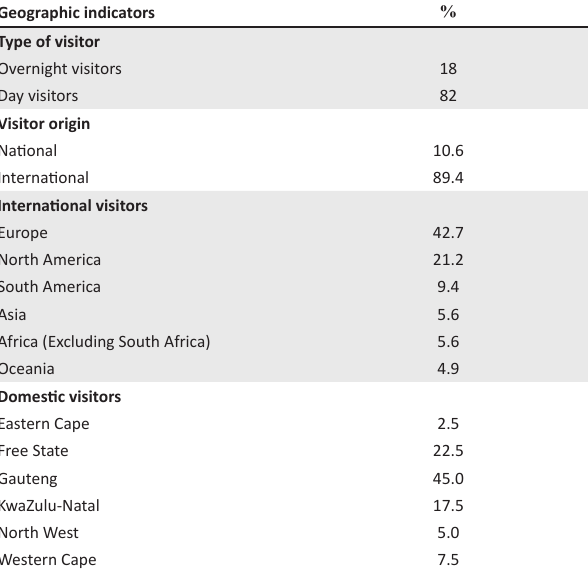
TABLE 1: Geographic profile. Geographic indicators